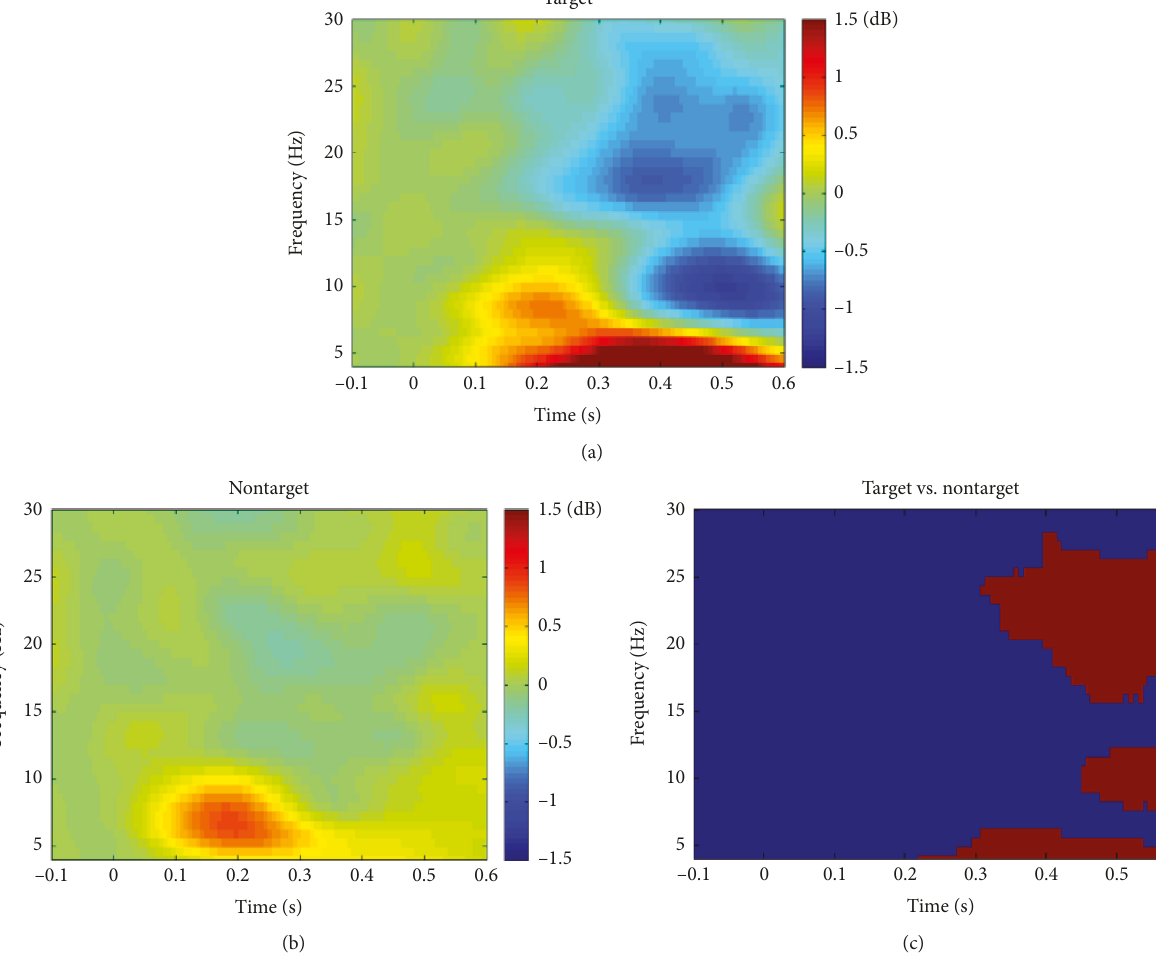
Figure 2: Spectral power changes averaged over 8 channels (P7, P3, Pz, P4, P8, O1, Oz, and O2) and plotted as 10log10 change over a baseline for target condition (a) and nontarget condition (b). (c) The comparison of ERSP between two conditions: red color indicates time-frequency regions signi fi cantly di ff erent between two conditions ( p < 0 0021 , FDR corrected) and blue color indicates no signi fi cant di ff